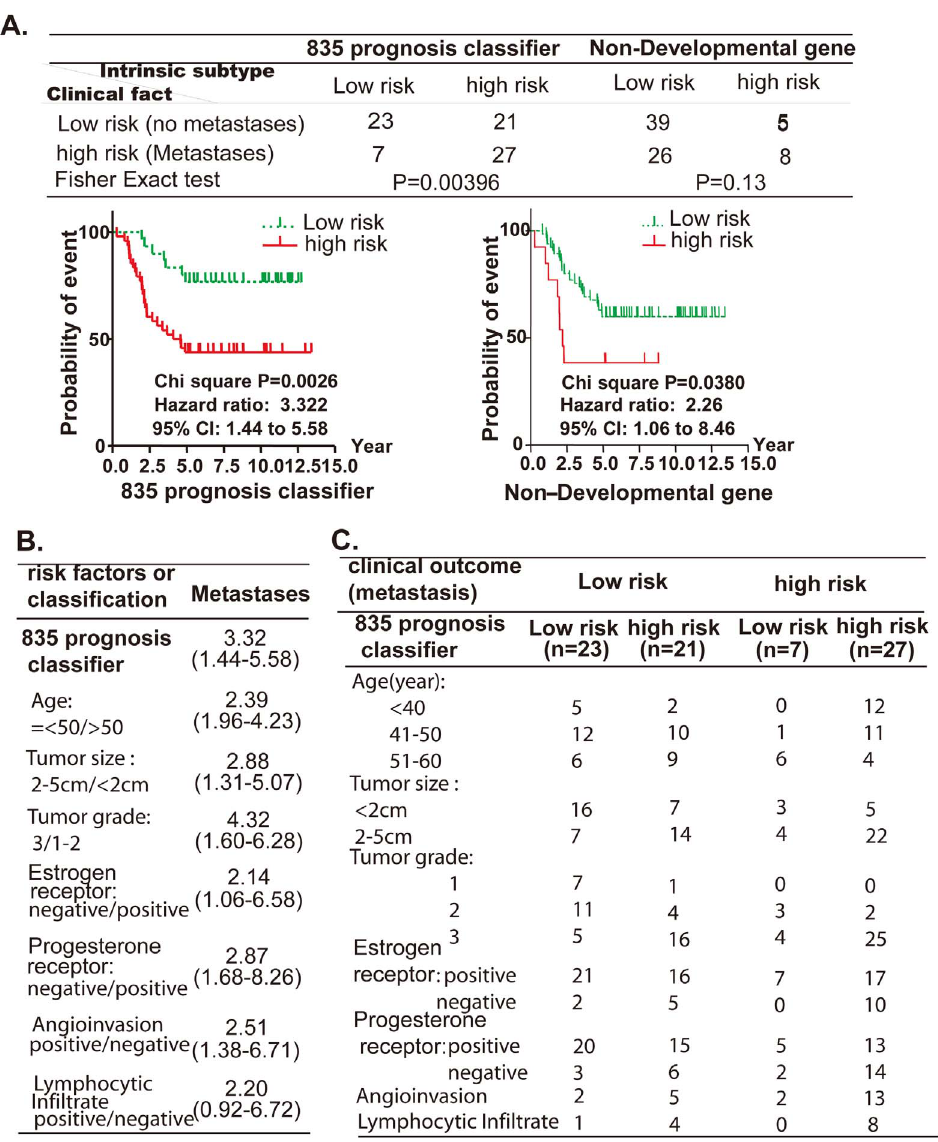
Figure 5. The 835 prognosis classifier acts as a powerful predictor of clinical outcome in 78 breast cancer patients. A. 78 breast cancer samples were first classified by the expression profiles of the 835 prognosis classifier, using unsupervised classification. The survival curve of the two groups was then compared with Kaplan Meier analysis to define clinical outcome (lower panel). Accuracy of classification was assessed with Fisher exact test (upper table). B. The distribution of tumors risk factors in the four groups classified by clinical metastasis and by the 835 prognosis classifier. C. The prognostic value of the 835 prognosis classifier and tumor risk factors.